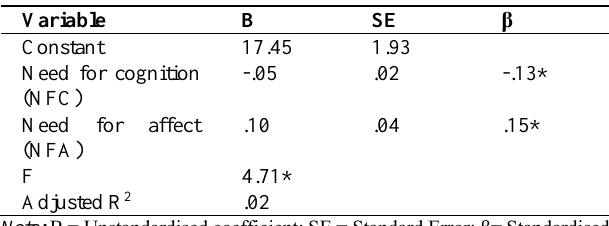
Table 2: Multiple regression analysis predicting visual content preference from personality traits